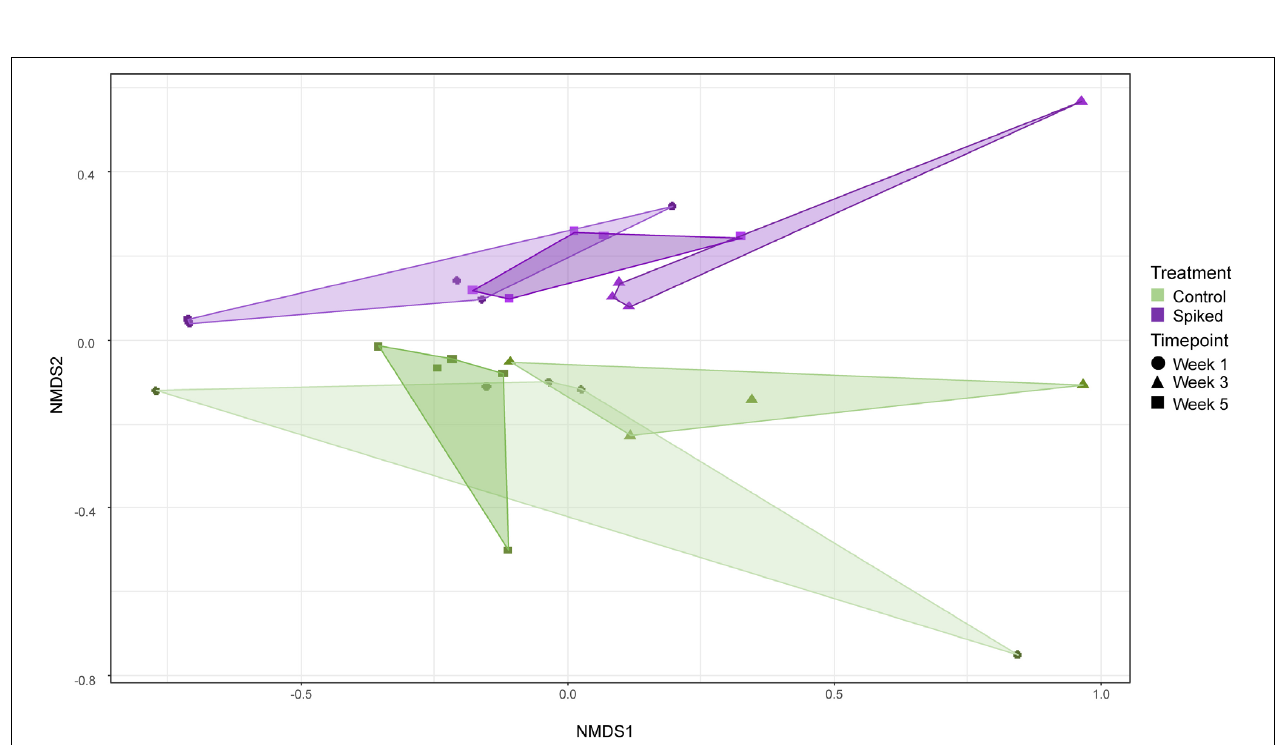
FIGURE 4 | NMDS of Bray-Curtis dissimilarities based on the relative abundance of all ASVs classified as bacteria (stress = 0.02). Different colors represent the two experimental treatments (with green denoting controls, and purple sediment spiked with the chemical mixture). The shaped points denote samples taken in the different